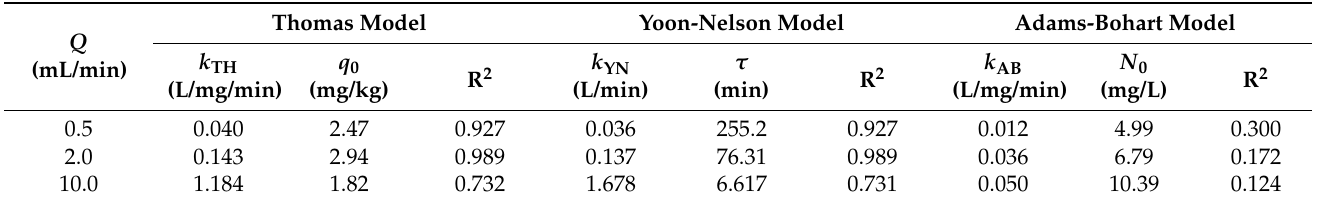
Table 2. Parameters of Thomas, Yoon-Nelson, and Adams-Bohart models for As column.